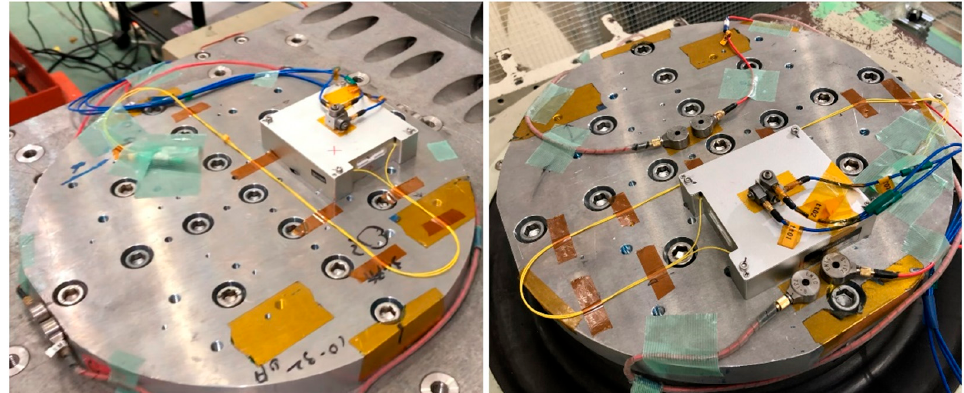
Figure 7. EDFA module during vibration tests on the X-Y horizontal vibration bench ( left ) and Z vertical vibration bench ( right ).